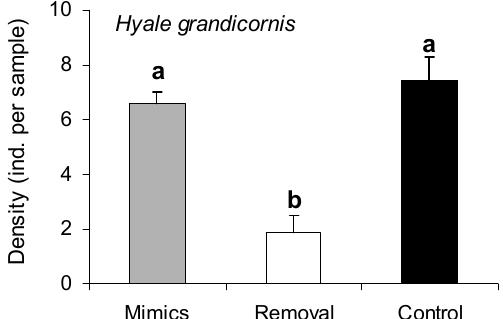
Figure 7. Mean (SE) densities of the grazing amphipod Hyale grandicornis in Porphyra -covered areas (control), Porphyra -removal plots, and removal plots where structural Porphyra mimics (“rip stop” nylon cloth strips) were added to a similar cover than controls (60–75%). The experiment was conducted at one site (Las Brusquitas) during December 2018, coinciding with peak Porphyra cover. Different letters above bars indicate significant differences.